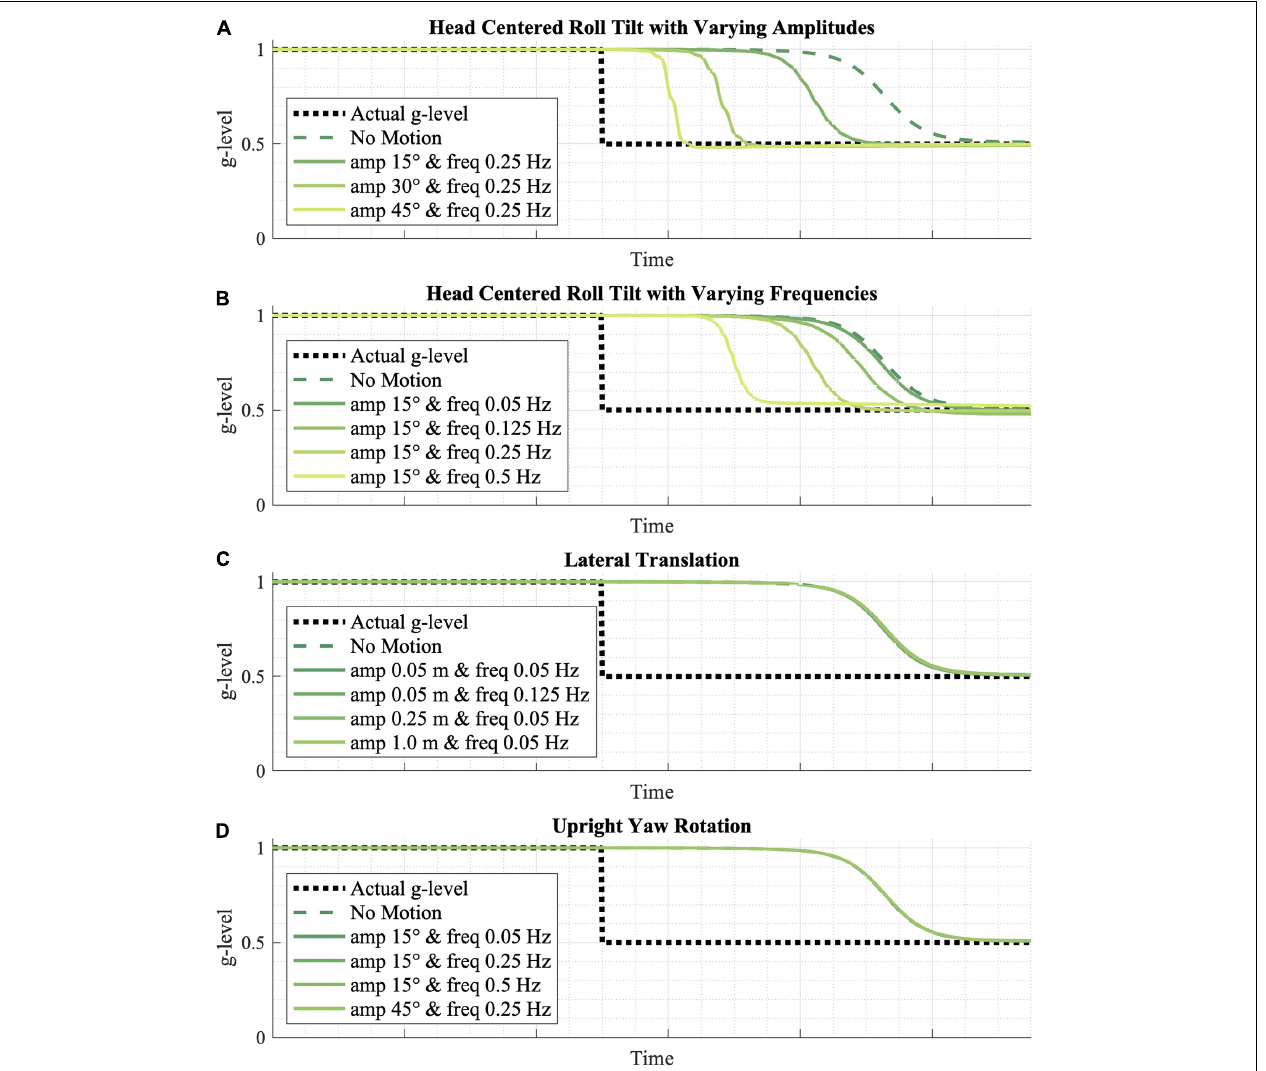
FIGURE 5 | The effect of various passive motion profiles on gravity adaptation. (A,B) Passive roll-tilt, (C) translation, and (D) upright yaw rotation motion profiles were simulated, predicting that varying frequencies and magnitudes of upright yaw and lateral translation yield no effect on the gravity adaptation process, while higher frequency and higher amplitude roll-tilt motion profiles speed up the adaptation